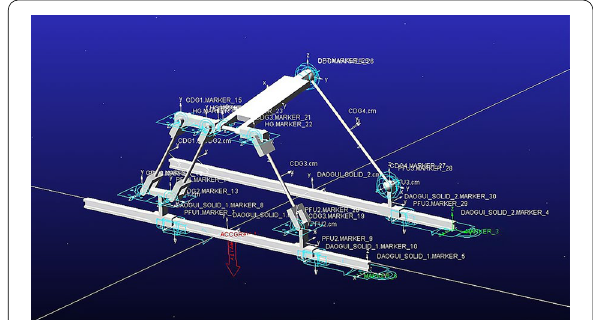
Figure 9 Virtual prototype of 2T1R parallel mechanism